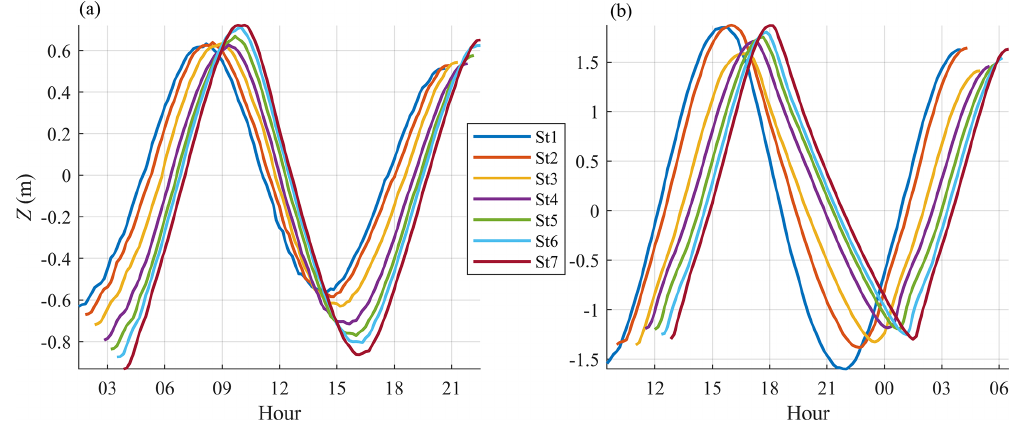
Figure 6. Water level variations ( Z ; metres) at stations St0–6 for (a) neap (24 August 2015) and (b) spring (31 August 2015)